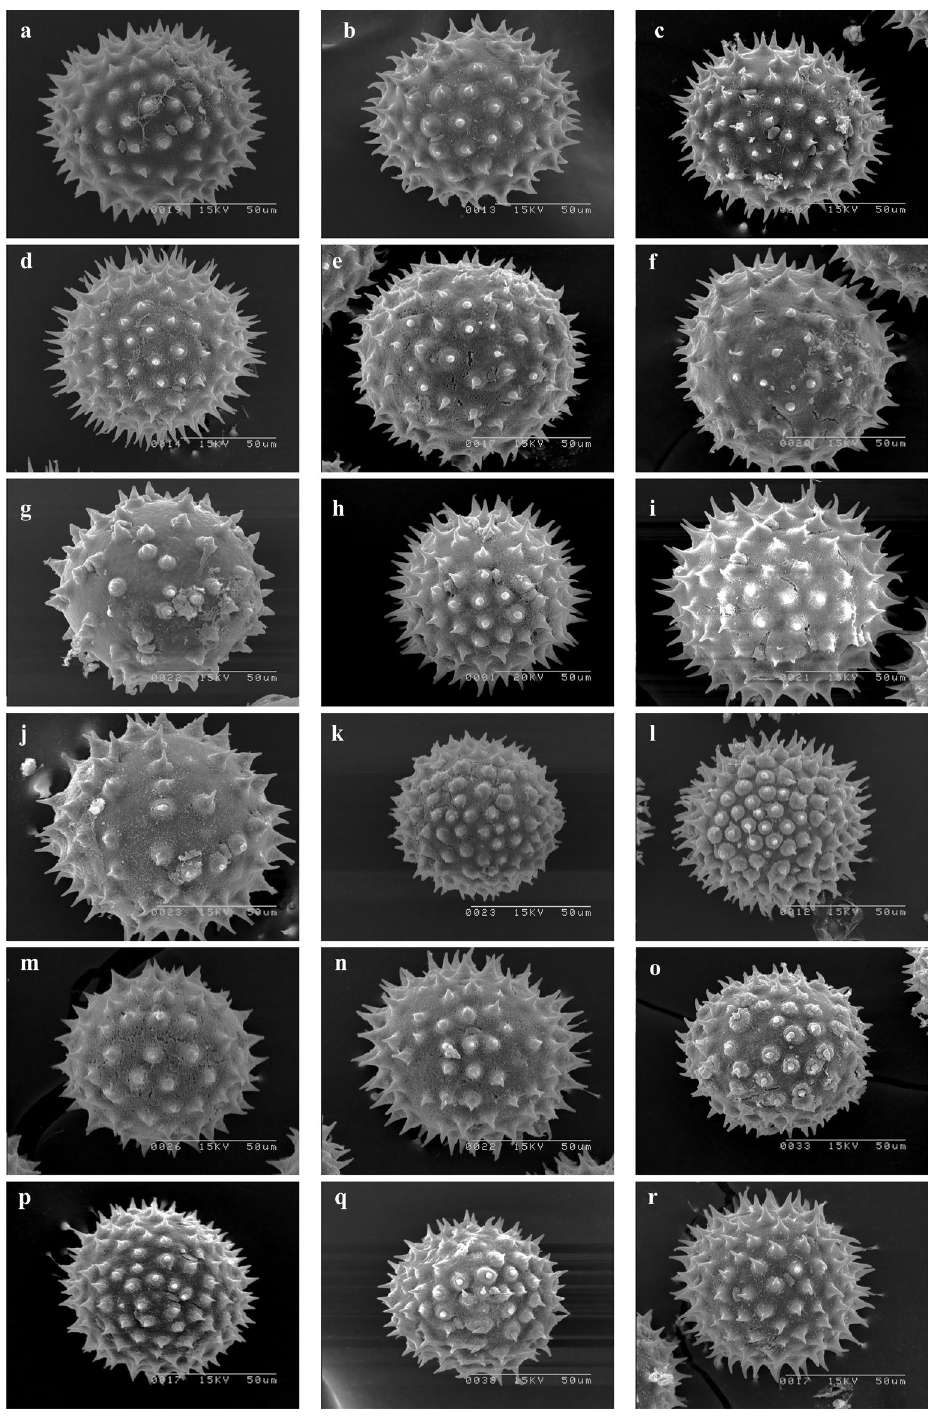
Fig. 1 SEM micrographs of pollen grains in Gossypium . a G. hirsutum (CRI12), b G. barbadense (CL), c G. barbadense (YM), d G. barbadense (XH7), e G. tomentosum (LZ), f G. tomentosum (JFZ8), g G. tomentosum (01), h G. mustelinum (LZ), i G. mustelinum (16), j G. darwinii (07), k G. herbaceum (ZC1), l G. herbaceum (africanum), m G. arboreum (SXY), n G. arboreum (Rozi), o G. anomalum (LZ), p G. capitis-viridis (LZ), q G. capitis-viridis (01), r G. thurberi (LZ), s G. thurberi (35), t G. armourianum (LZ) u G. harknessii (LZ), v G. davidsonii (LZ), w G. klotzschianum (LZ), x G. raimondii (01), y G. gossypioide s (LZ), z G. schwendimani i (LZ), aa G. stocksii (LZ), ab G. somalense (LZ), ac G. areysianum (LZ), ad G. incanum (04), ae G. bickii (LZ), af G. australe (LZ), ag G. rotundifolium (LZ). Scale bar: 50 μm. Accelerating voltage: 15